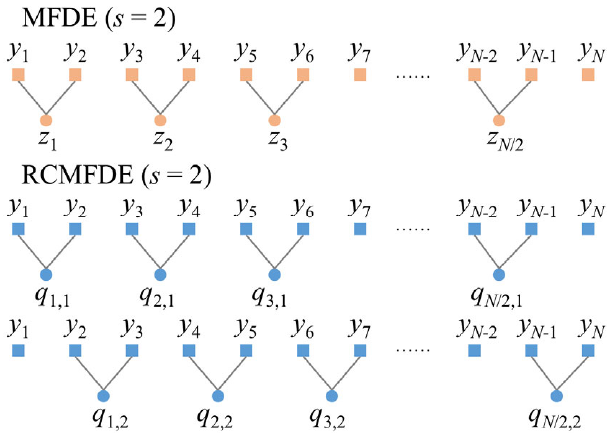
Figure 2. Comparison of two coarse ‐ grained techniques.